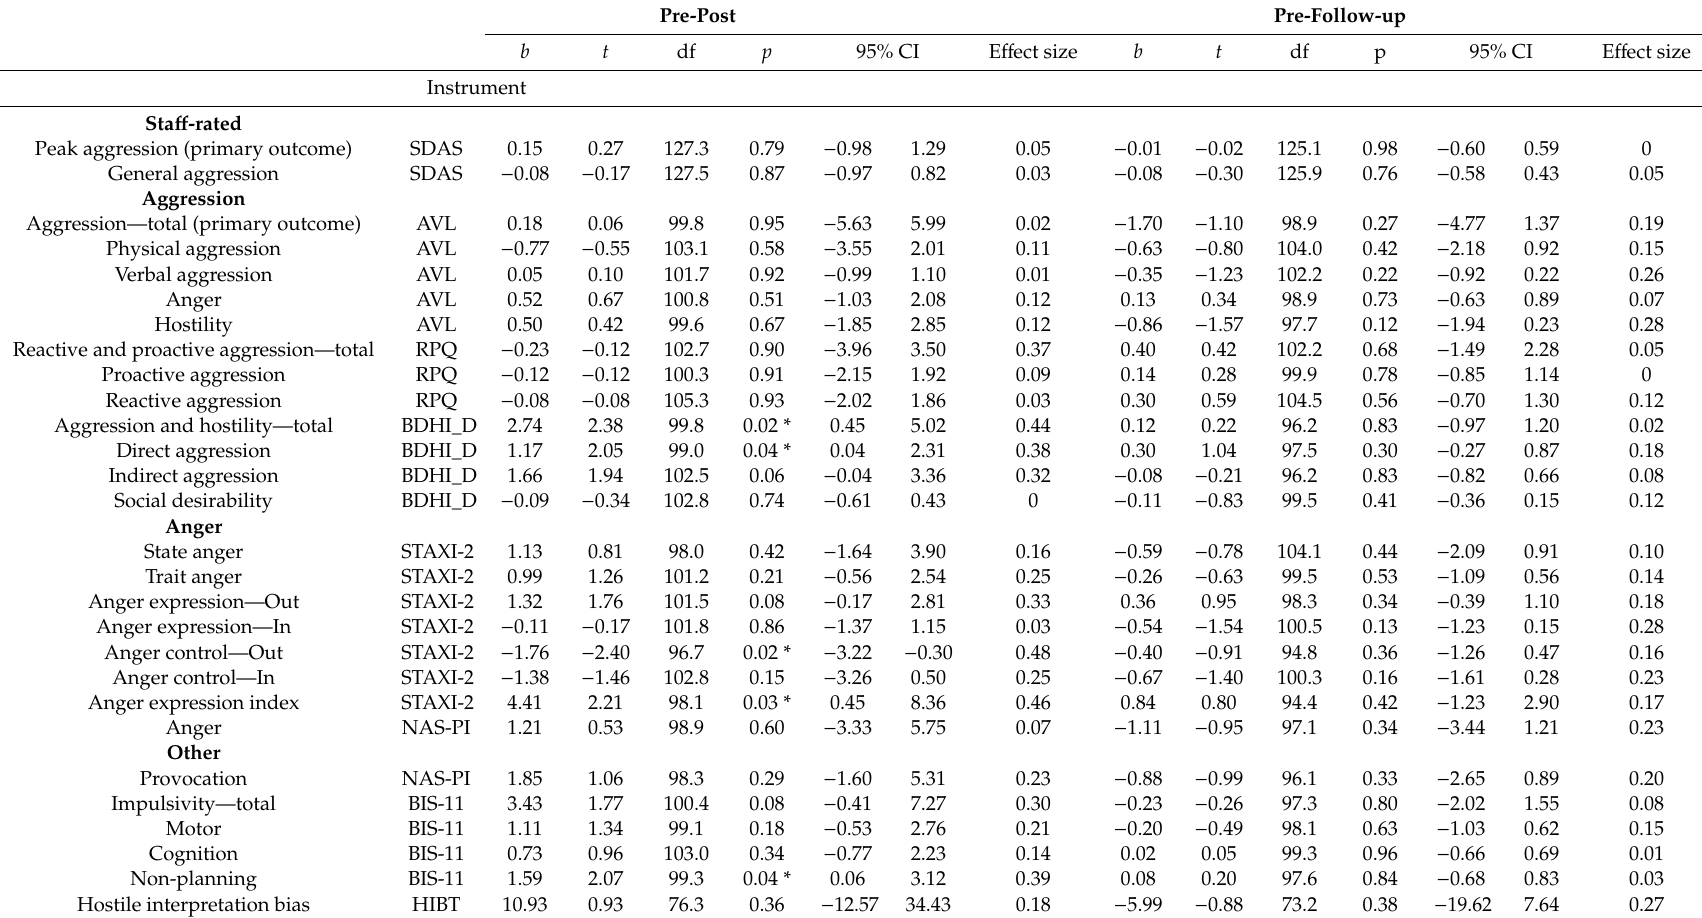
Table 3. Estimates of treatment e ff ects from multilevel regression